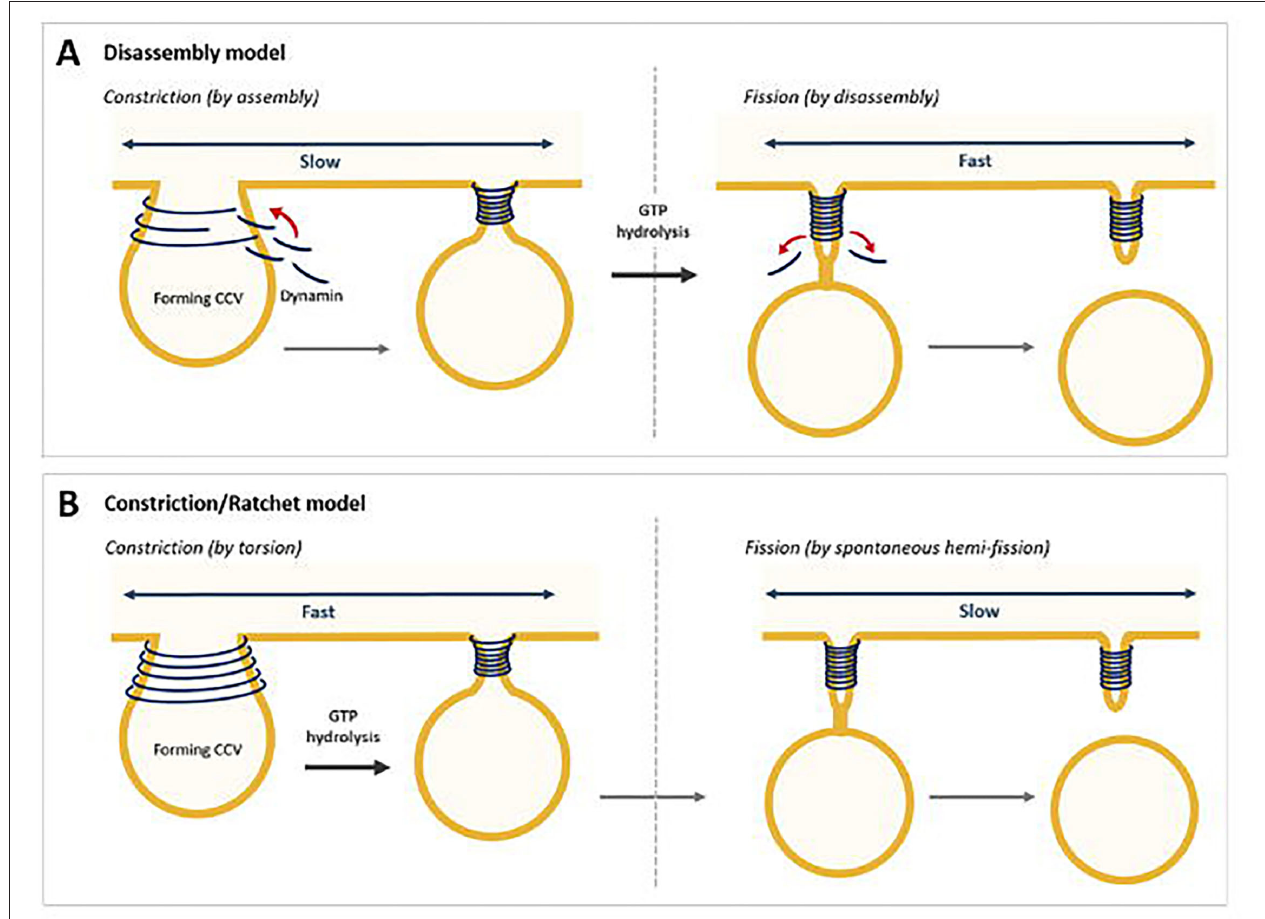
FIGURE 6 | Two models for dynamin-mediated membrane fission. (A) Two-stage fission model, where constriction is mediated by assembly and fission by disassembly. (B) The constriction/ratchet model, where constriction is achieved by active sliding of the helical turns and induce fission ( Chen et al.,